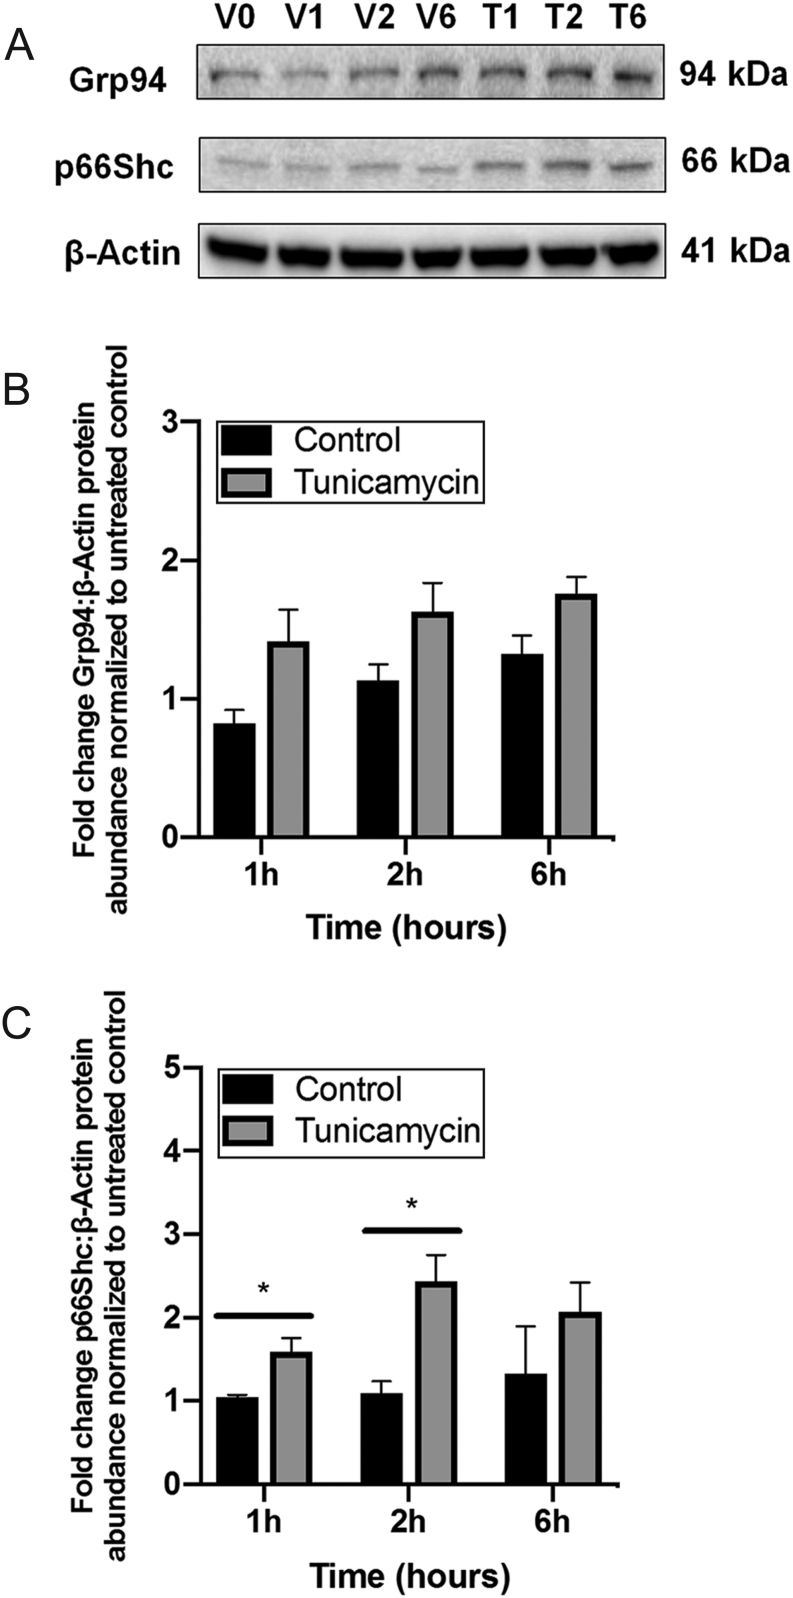
Induction of ER stress with tunicamycin results in increased protein abundance of p66Shc in the HepG2 cell line. (A) Representative Western blots illustrating protein abundance of GRP94 and p66Shc in HepG2 cells treated with either DMSO vehicular control for 1 h (V1), 2 h (V2) or 6 h (V6), or 0.5 µg/mL tunicamycin for 1 h (T1), 2 h (T2) or 6 h (T6). Fold change difference of (B) p66Shc and (C) GRP94 were expressed as means from three biological replicates normalized to β-Actin ± s.e.m., and again normalized to untreated control cells at 0 h (V0). Protein abundances for each time point were analyzed using a two-tailed unpaired Student’s t-test. *Significant difference (P < 0.05).